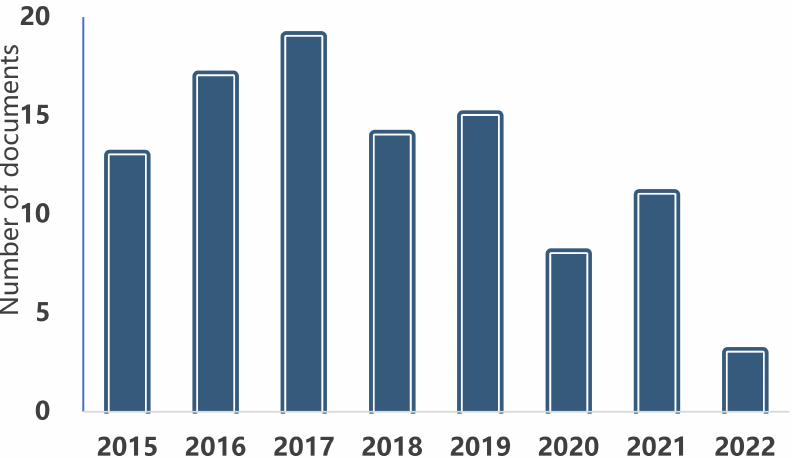
Figure 1. Documents on formation of C–C bonds and C–Heteroatom bonds catalyzed by I 2 /DMSO.